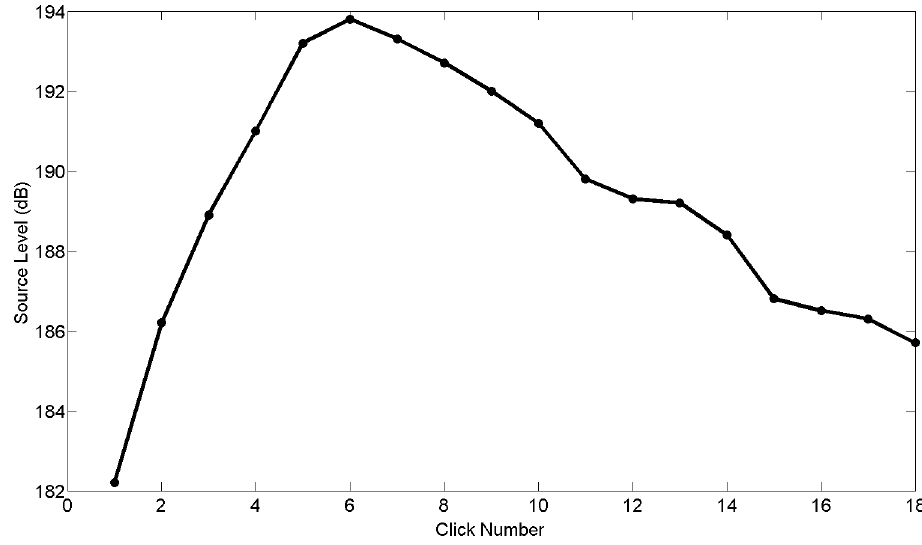
Figure 2. An example trial produced by the dolphin. Source levels start out around 170–180 dB, increase by 10–20 dB over a few clicks, reach maximum amplitude, and then slowly decrease. Source levels were calculated from the peak-to-peak voltage and reported in dB re: 1 m Pa.